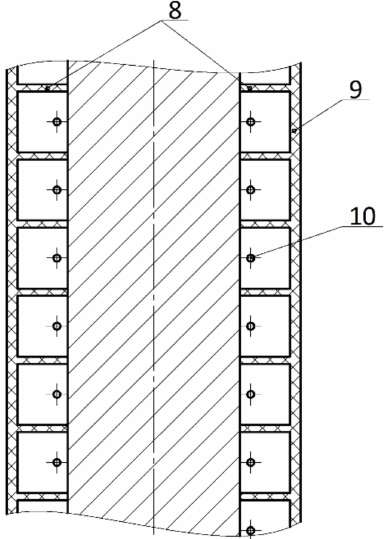
Figure 3. Unfolded drawing of seals and throttling cavities.